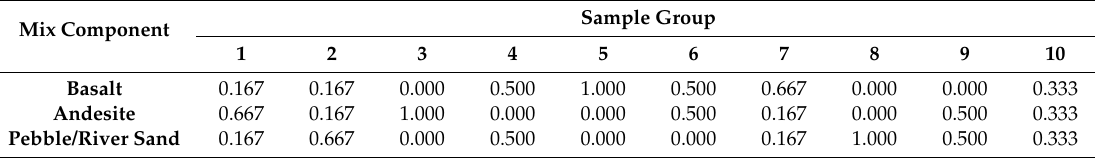
Table 5. Experimental proportion design based on simplex lattice design (SLD).